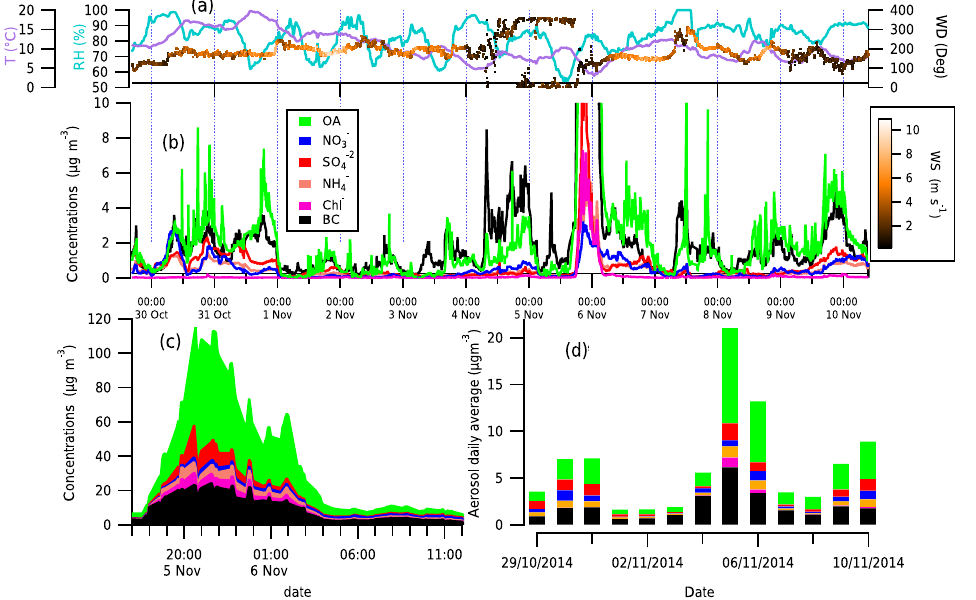
Figure 1. Meteorology (a) , aerosol concentrations during all measurement periods (b) . Chemical component mass concentrations during Bonfire Night plotted cumulatively (c) . Daily aerosol concentrations (d)